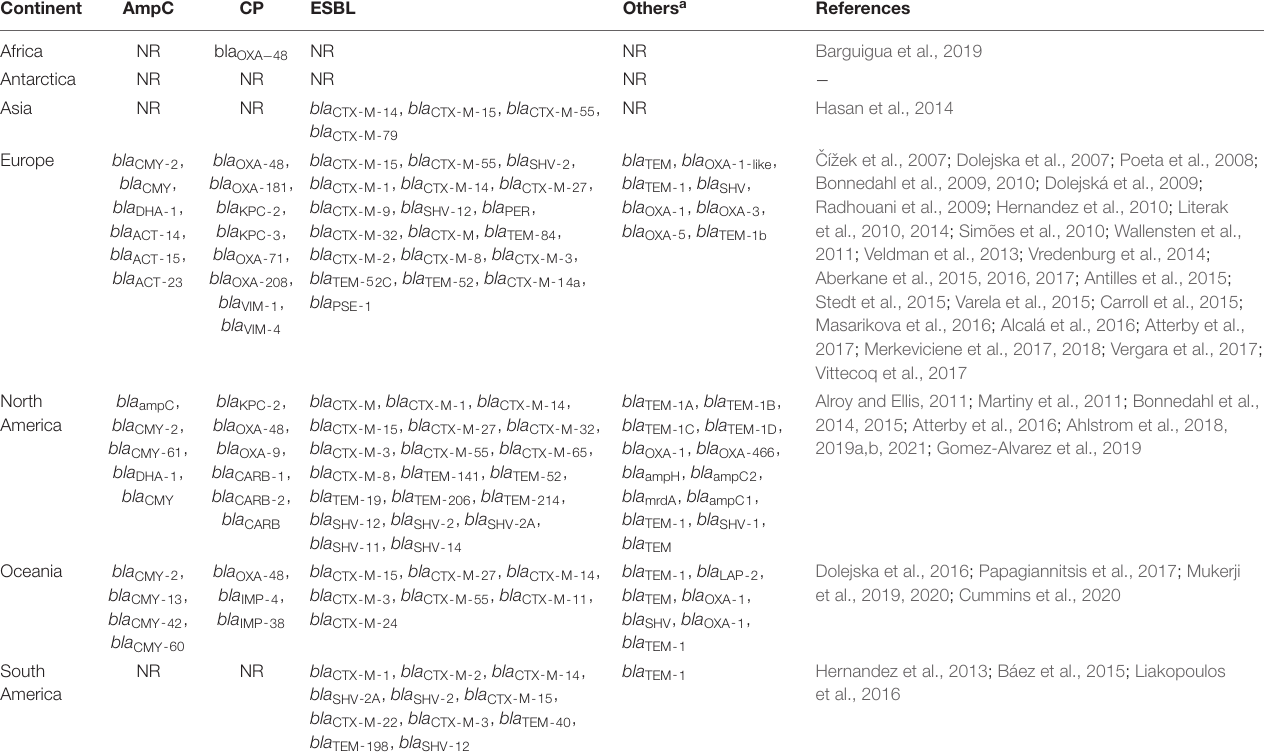
TABLE 3 | Beta-lactamases genes identified in isolates from gulls reported between 1981 and 2020. Continent AmpC CP ESBL Others